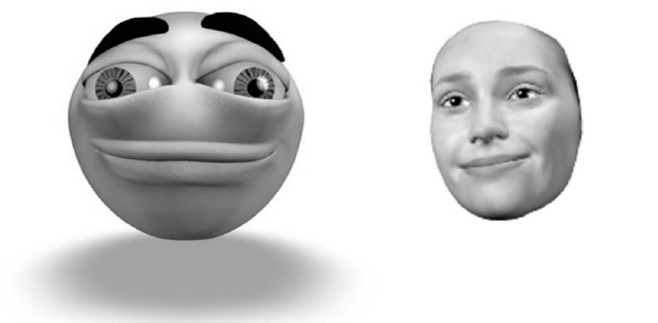
Fig 9. Character avatar synthesis for the melancholy smile .